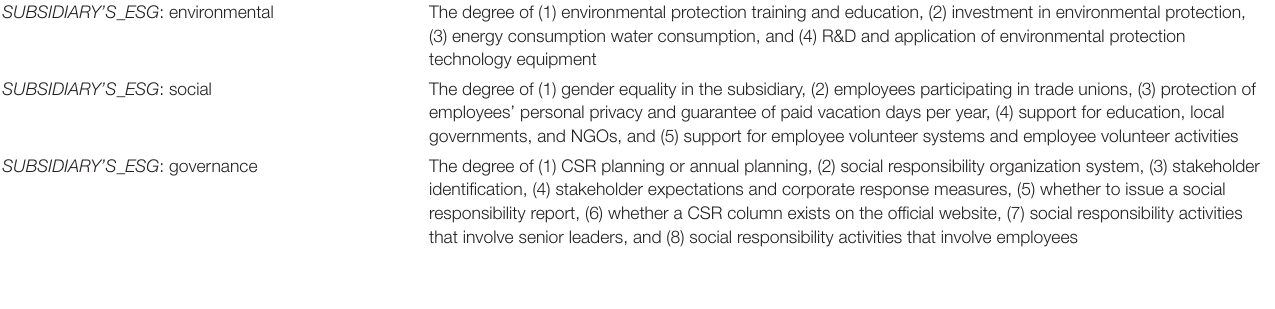
TABLE A1 | Detailed items of